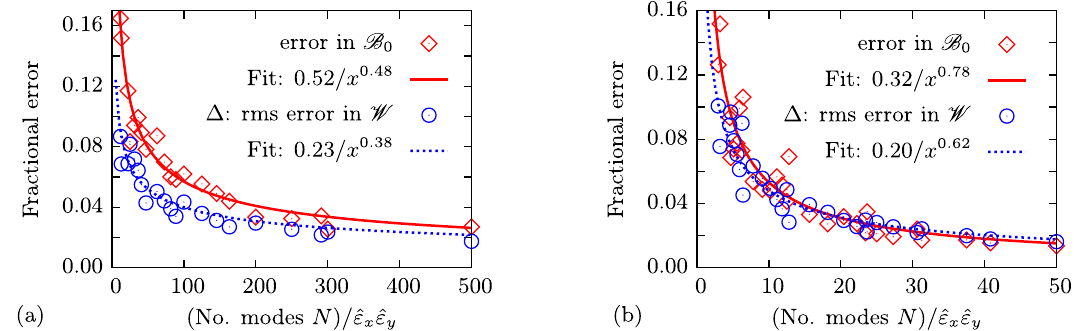
FIG. 7. Dependence of two measures of the error in the coherence function as a function of the number of simulated modes per unit phase space area. As shown in (a), distributing the electrons randomly results in rather slow convergence, requiring ∼ 150 modes per ˆ ε transverse area ˆ ε to achieve ≲ 5% accuracy. On the other hand, panel (b) demonstrates that employing a low-discrepancy sequence to x y distribute the electrons significantly reduces the required number of electrons; here, about 15 modes per ˆ ε error of ≲ 5% . This number is a little more than 4 times the number of modes required for the orthogonal expansion valid when ˆ ε and about 5 times more than the Gaussian-Schell model